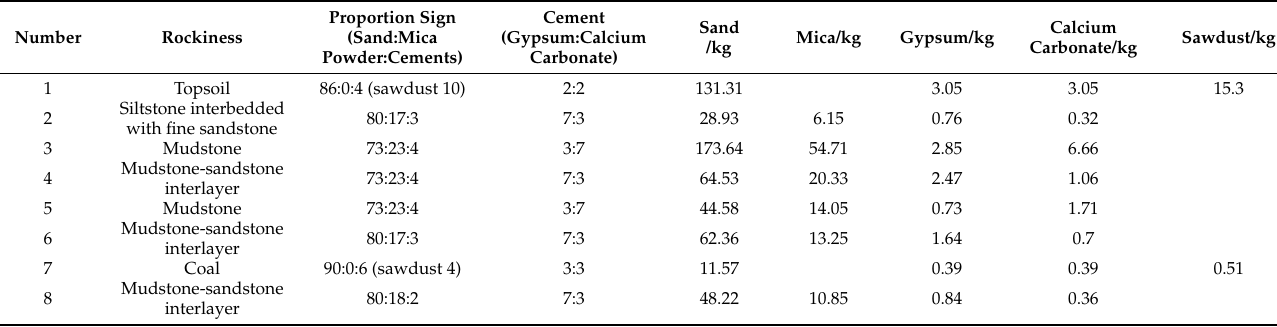
Table 8. Table of model material